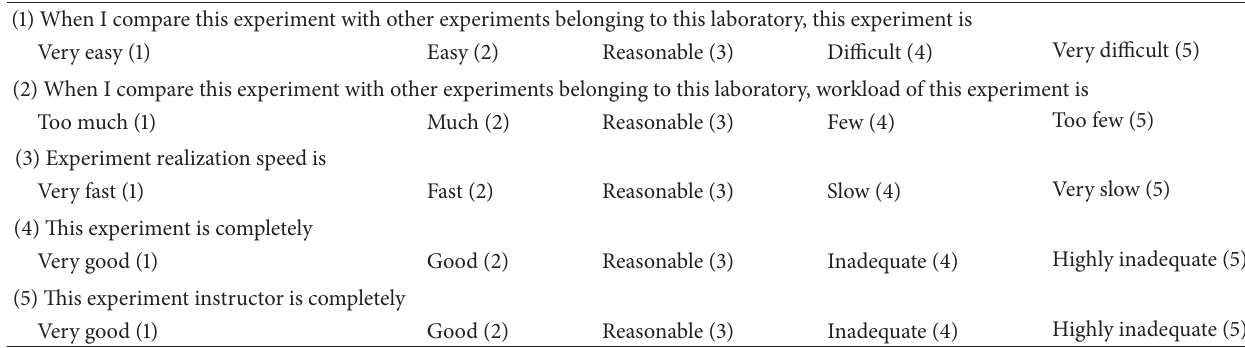
Table 5: Assessment data student evaluations (Section-A).